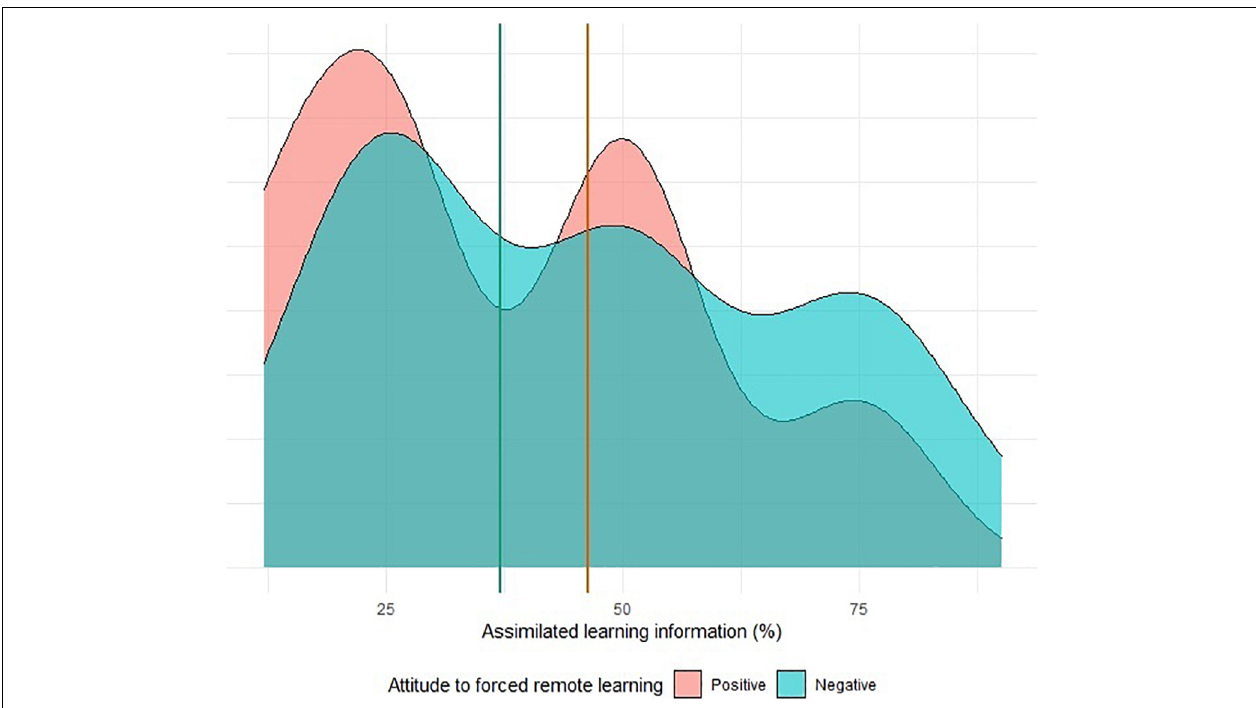
FIGURE 1 | Probability density function of the percentage of assimilated information with respect to attitude toward remote learning. The vertical lines indicate group